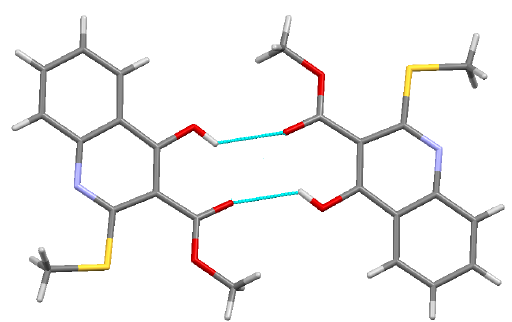
Figure 5. Molecular structure of compound 3 according to X-ray diffraction data. Thermal displacement ellipsoids are shown at the 50% probability level.